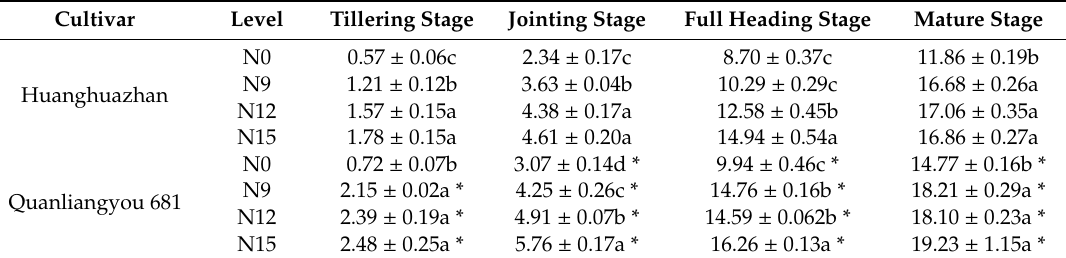
Table 1. Dry weight (t / hm 2 ) of rice cultivars under Nitrogen (N) treatment at di ff erent levels in di ff erent stages.